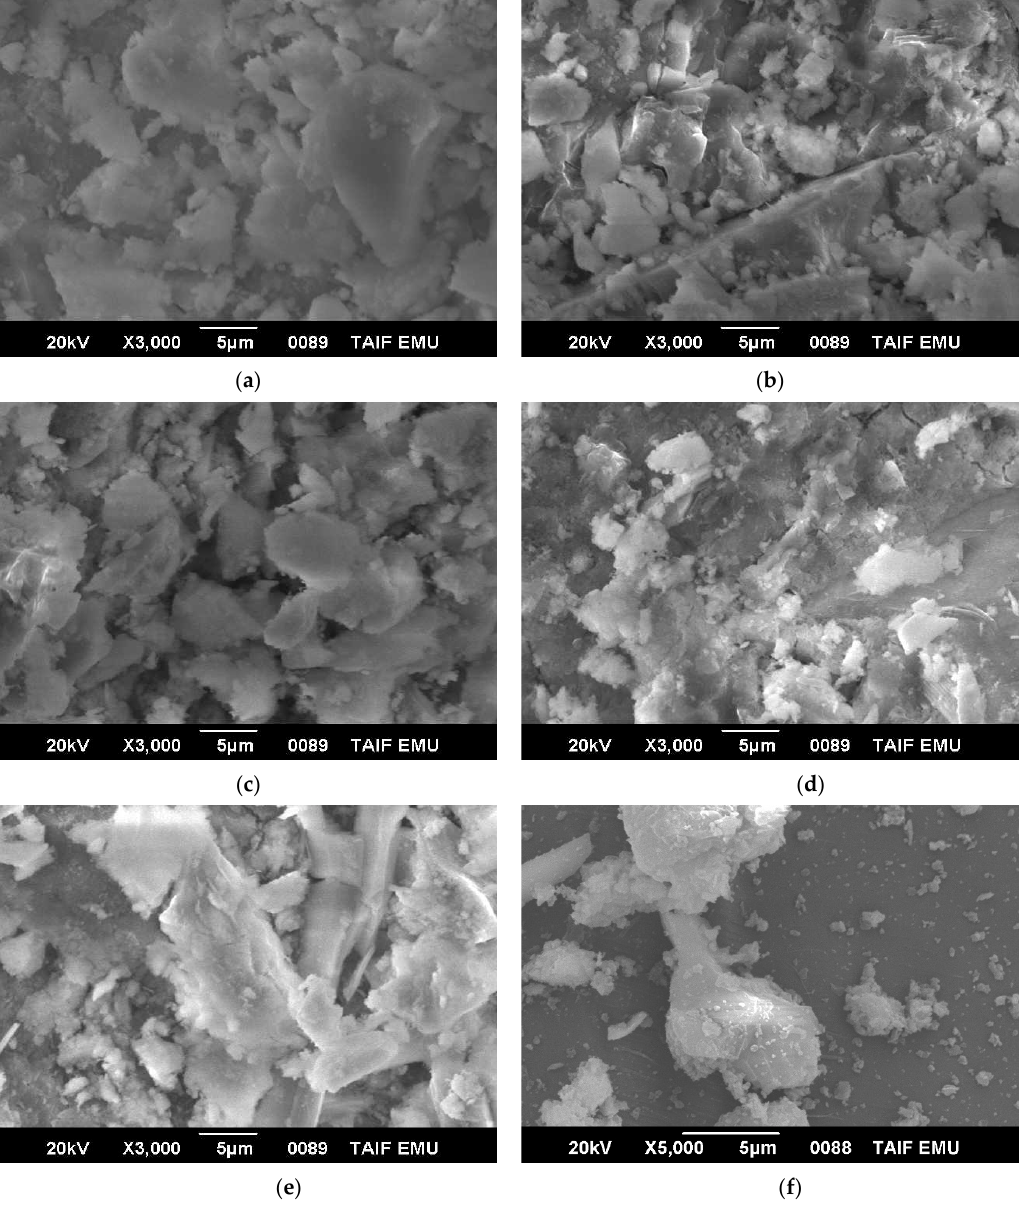
Figure 16. SEM of all tested concrete mixes: ( a ) M2 (40% RFCA); ( b ) M9 (40% RFNA); ( c ) M6 (10% RCP); ( d ) M13 (10% AMF); ( e ) M16 (10% SF); ( f ) M0.